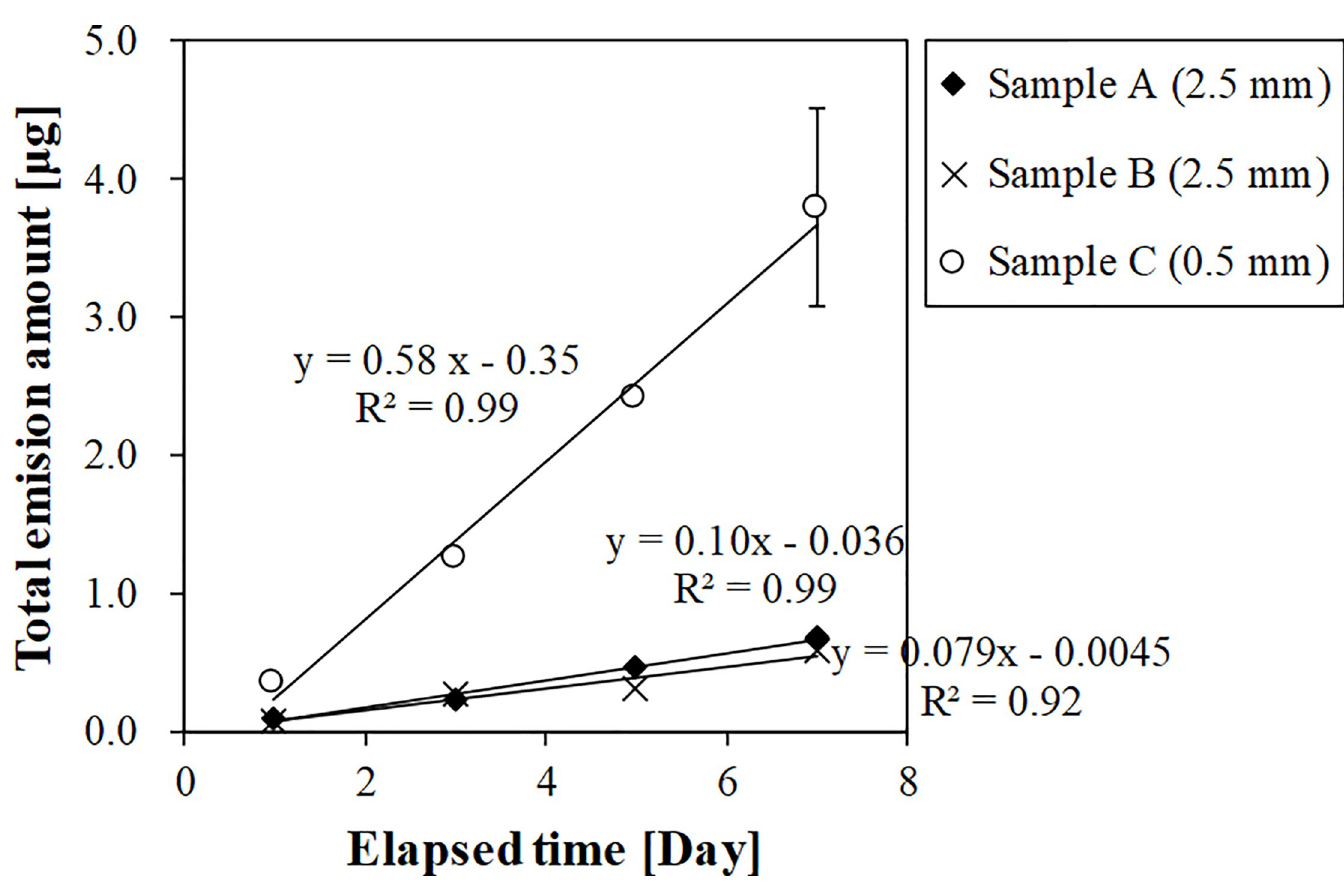
Fig 3. DEHP total emission amounts from samples A, B, and C over 7